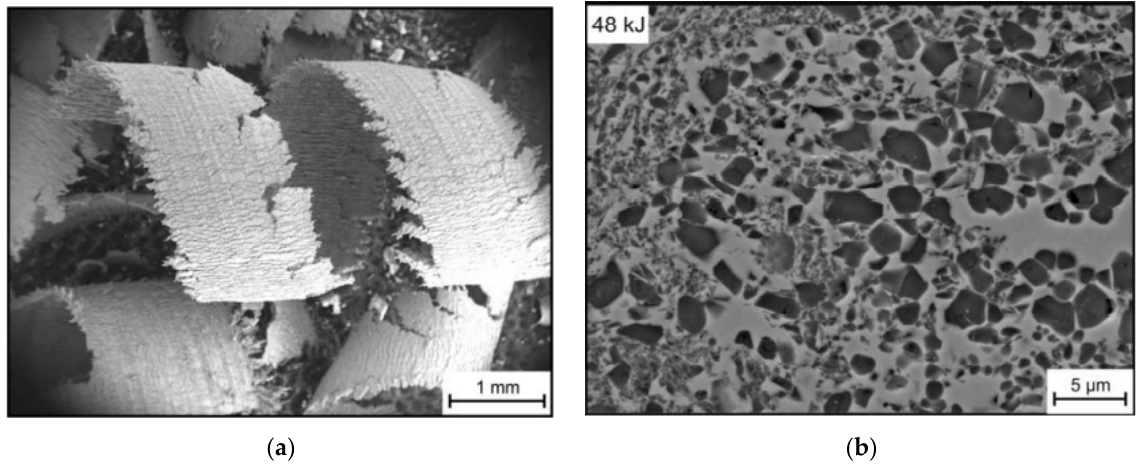
Figure 10. Ferro-Titanit used in experiments: ( a ) chips obtained after machining the bulk materials; ( b ) microstructure of the chips consolidated by EDC. Reprinted with permission from ref. [104] Copyright 2014 John Wiley and Sons.